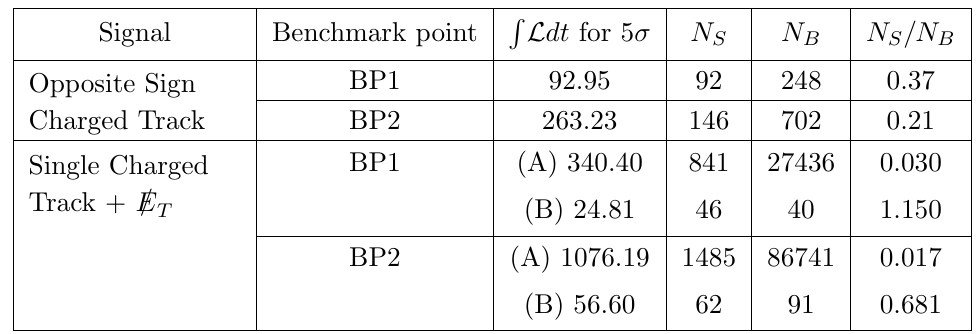
Table 4 . Integrated luminosity (fb (cid:0) 1 ) required to attain 5 (cid:27) statistical signi(cid:12)cance for opposite sign charged tracks and single charged track + =E signals for the considered Benchmark points of T table 2 in the Type III seesaw with a sterile neutrino model during 14 TeV run of